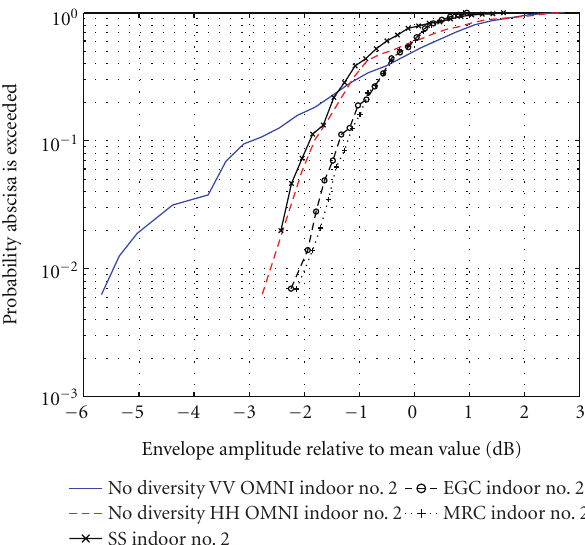
Figure 10: CDFs for di ff erent combination methods in indoor number 2 scenario at 61.5 GHz and omnidirectional receiver.